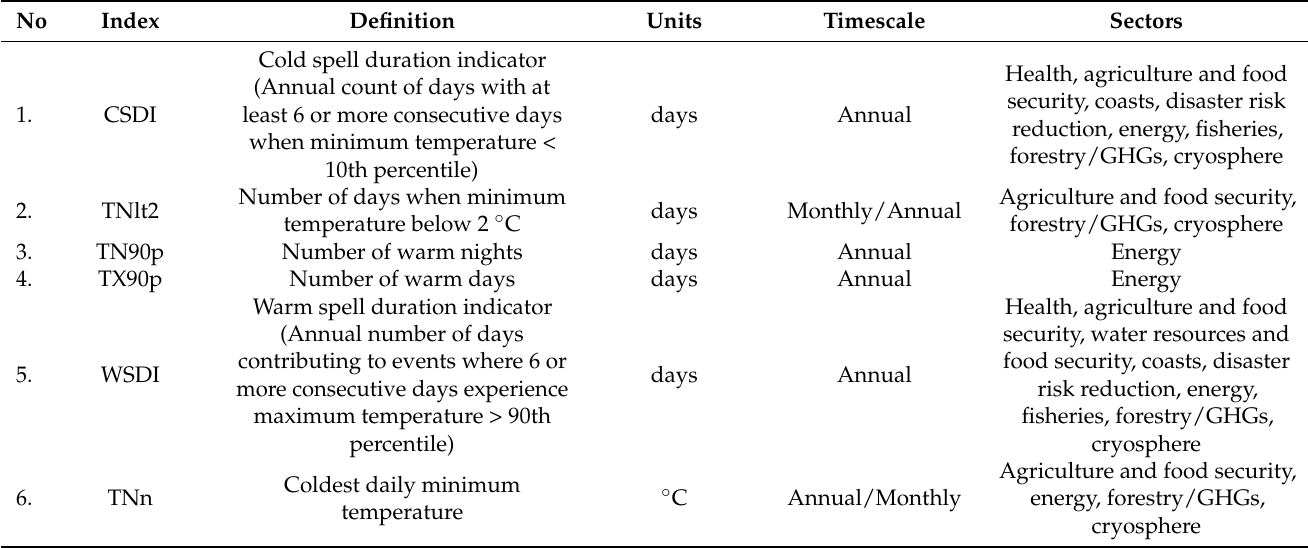
Table 2. List of ET-SCI Indices assessed in this